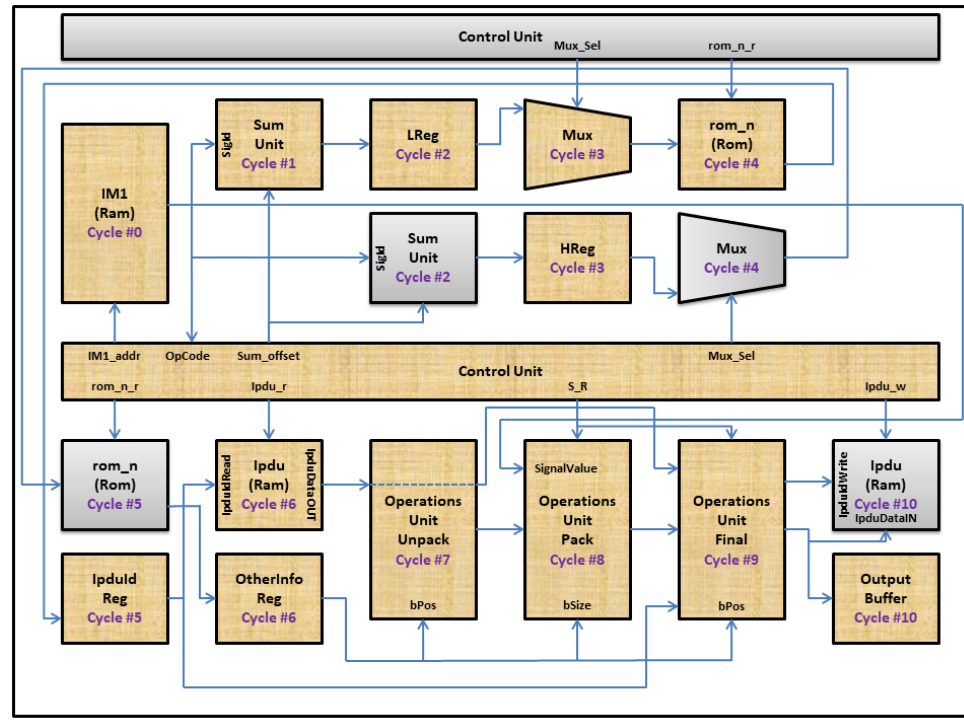
Figure 1. COM ASIP